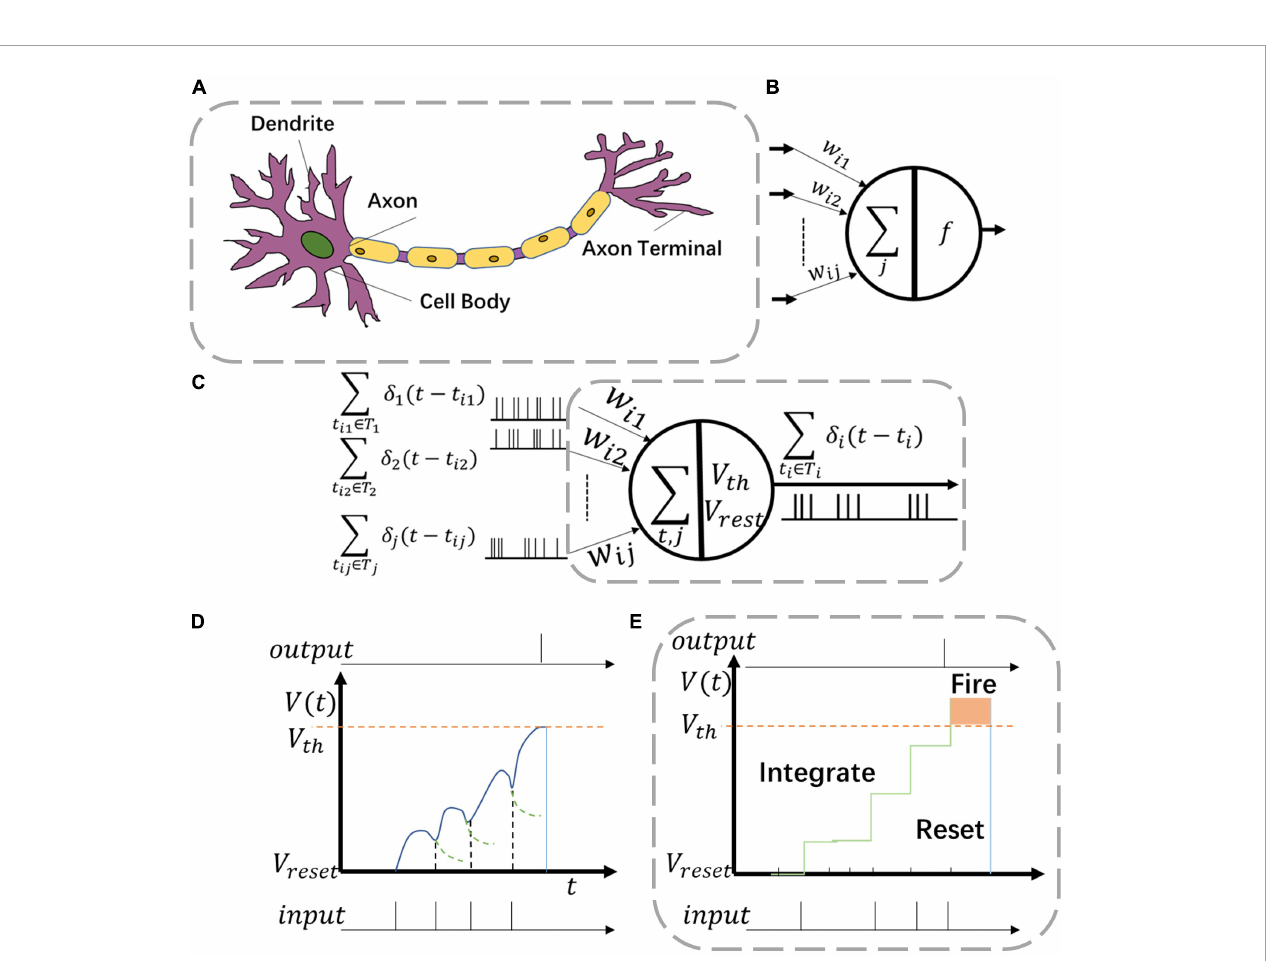
FIGURE3 Various neuron models including (A) biological neuron, (B) artificial neuron, and (C) neuromorphic neuron. Two kinds of behaviors in panel (C) are (D) leaky-integrate-fire (LIF) function and (E) integrate and fire (IF)